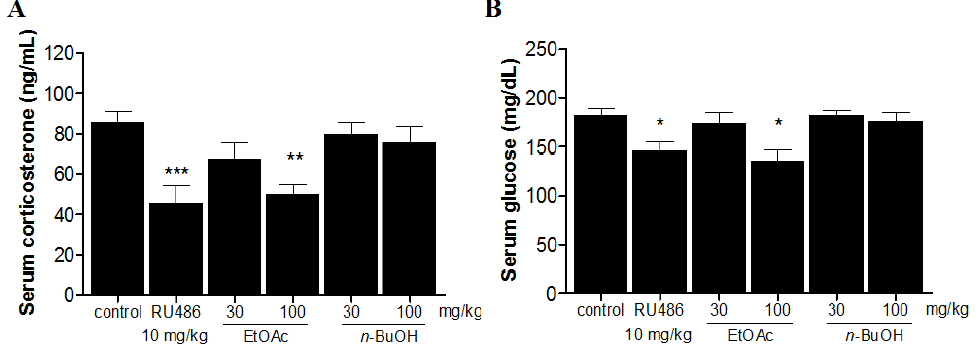
Figure 2. Effect of M. alba fractions on serum corticosterone ( A ) and glucose ( B ) levels. Data are mean ± SEM values ( n = 8 per group). * p < 0.05, ** p < 0.01, and *** p < 0.001 significantly different from control